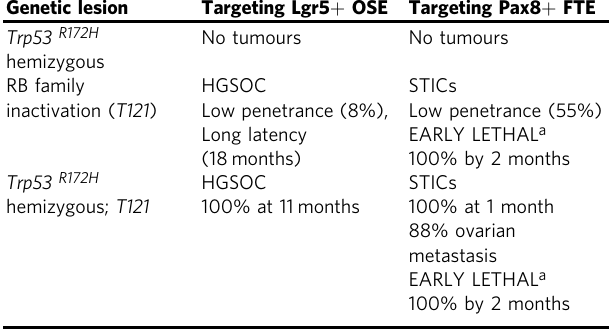
Table 1 Phenotypes of genetically engineered mouse models targeting genetic lesions to the OSE and FTE by Zhang et al. 2